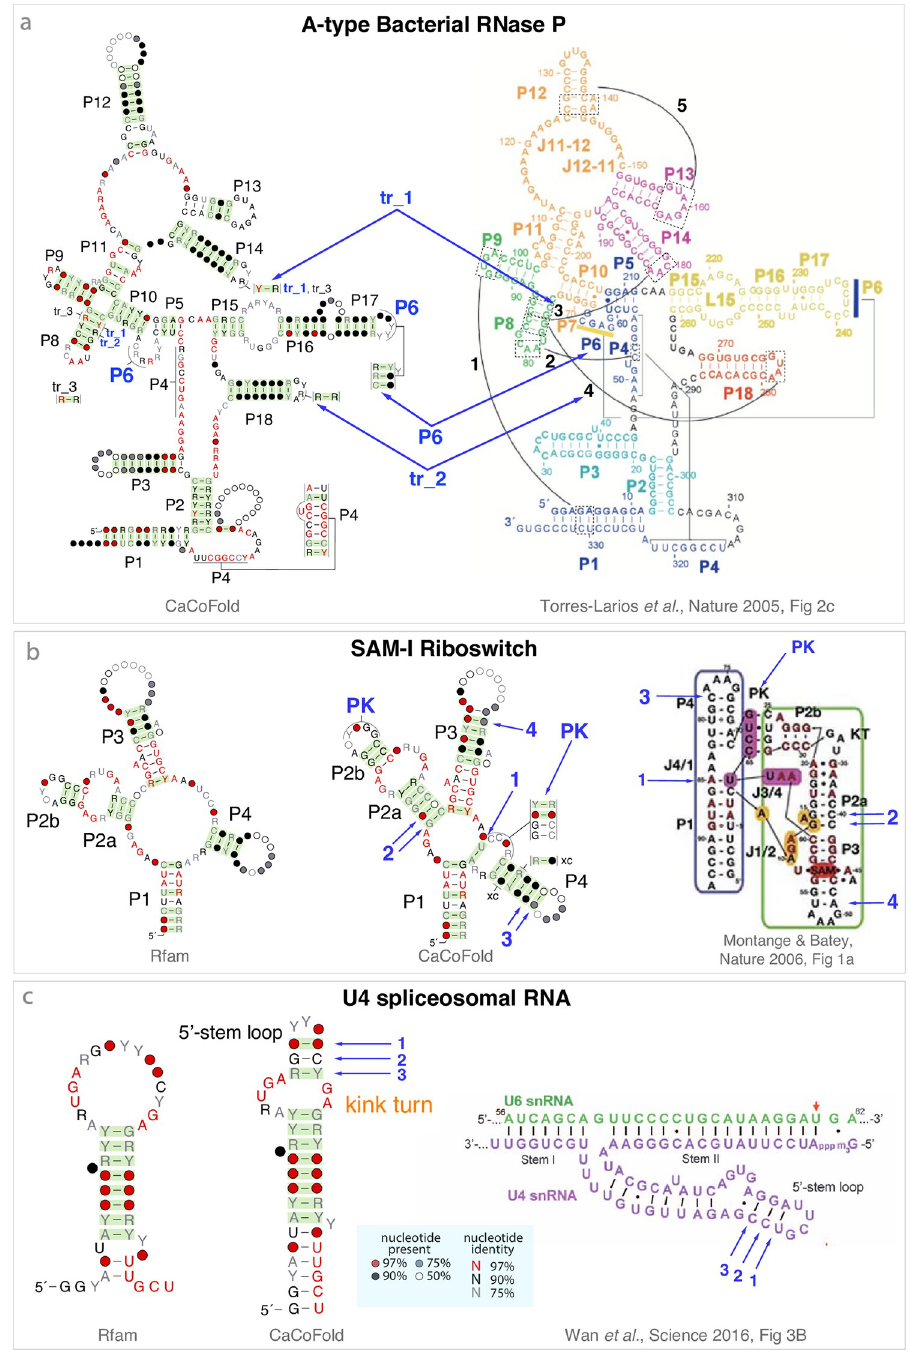
Fig 4. CaCoFold structures confirmed by known 3D structures (part 1/7). Structural elements with covariation support introduced by CaCoFold relative to the Rfam annotation and corroborated by 3D structures are annotated in blue. (a) The A-type RNase P RNA CaCoFold structure includes relative to the Rfam structure one more helix (P6) and two significant covariations, named tr_1 and tr_2. Blue arrows show the placement of these three covarying motifs relative to the 3D structure [46]. The display of the crystal structure has been modified to indicate with back shaded boxes five regions with tertiary interactions labeled “1” to “5”[68]. “tr_1” occurs in region “3” between P8 and the hairpin loop of P14, and “tr_2” in region “4” representing the interaction between P8 and the hairpin loop of P18. The display of the CaCoFold structure has been modified by hand to match the standard depiction of the structure. (b) The SAM-I riboswitch CaCoFold structure shows relative to the Rfam structure one more helix forming a pseudoknot,